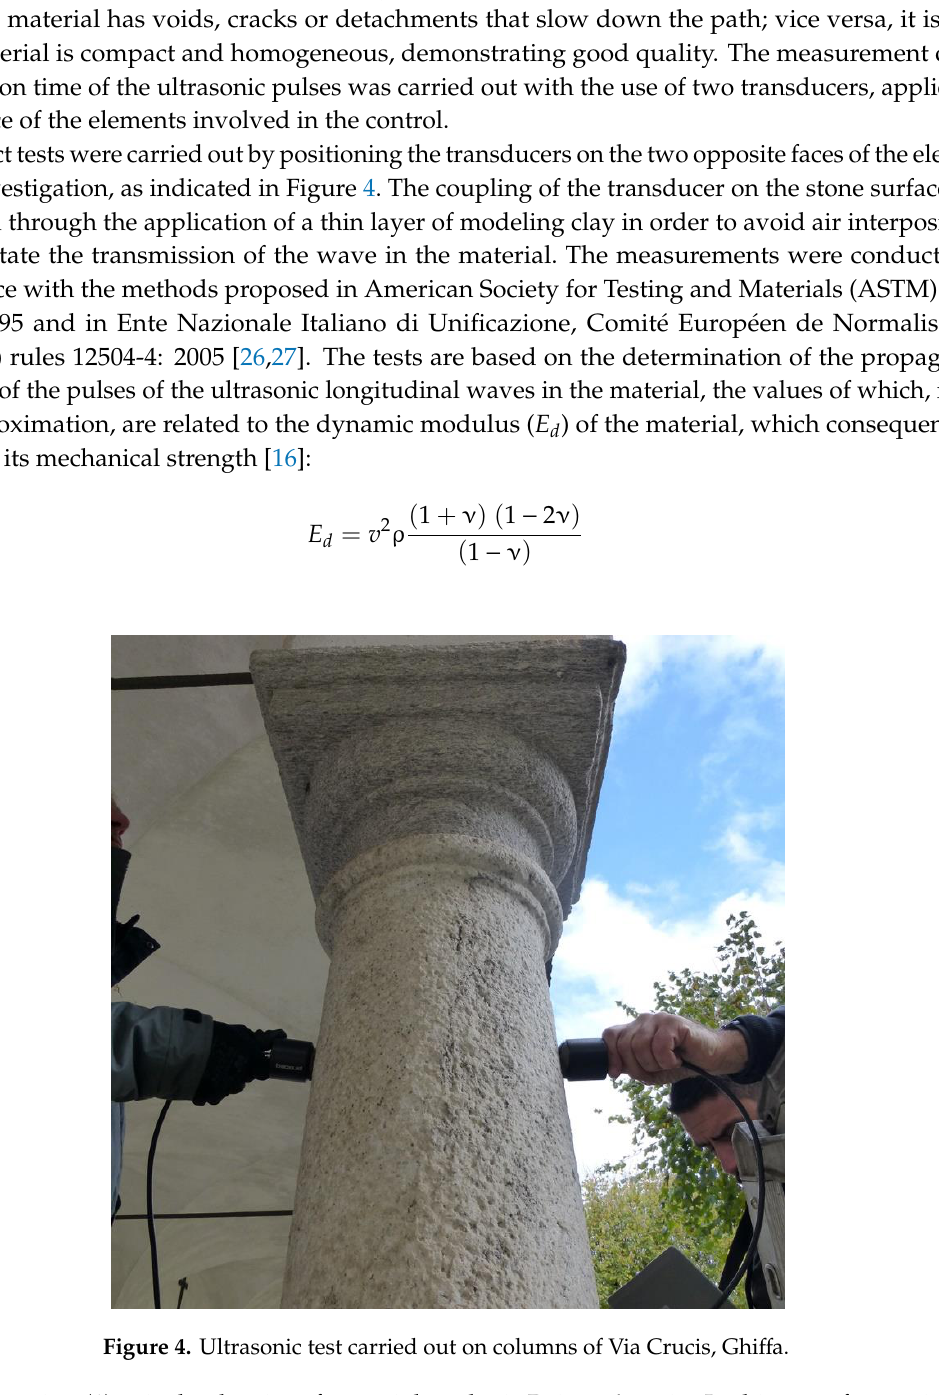
Figure 4. Ultrasonic test carried out on columns of Via Crucis, Ghiffa.